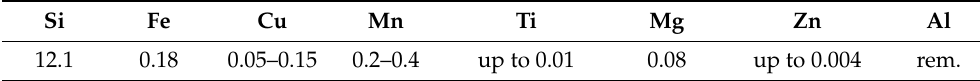
Table 1. AlSi12 alloy composition